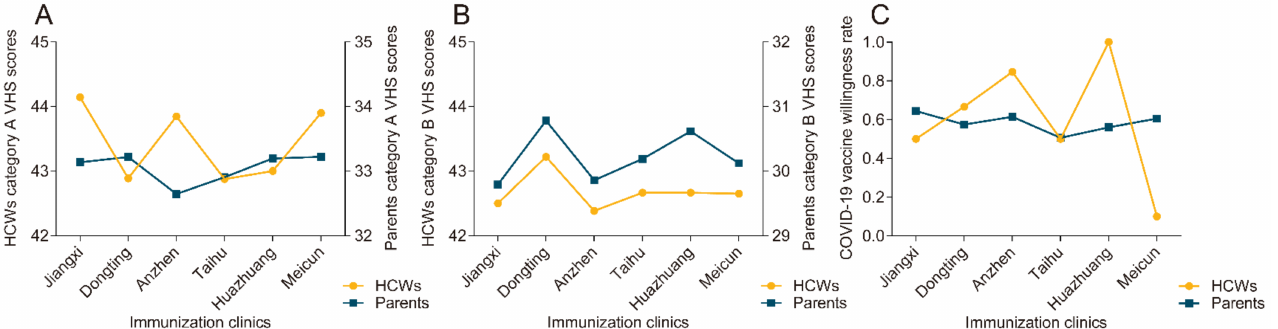
Figure 3. Relationship of vaccine hesitancy and willingness between parents and healthcare workers by immunization clinics. ( A ) Category A vaccine hesitancy between parents and healthcare workers by immunization clinics, r = 0.143, p = 0.787; ( B ): different category A vaccine hesitancy between parents and healthcare workers by immunization clinics, r = 0.928, p = 0.008; ( C ): COVID-19 vaccine willingness between parents and healthcare workers by immunization clinics, r = − 0.174, p = 0.742. HCWS = healthcare